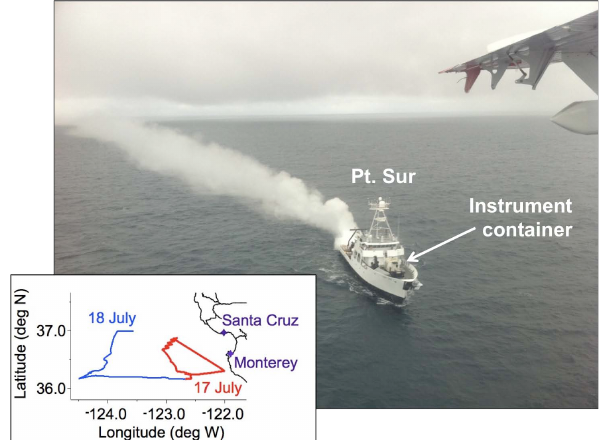
Fig. 1. Smoke generation on the R/V Point Sur (photo taken from CIRPAS Twin Otter). Insert: General area of the E-PEACE field campaign off the coast of California. The ship’s course is shown for the days that are the focus of this